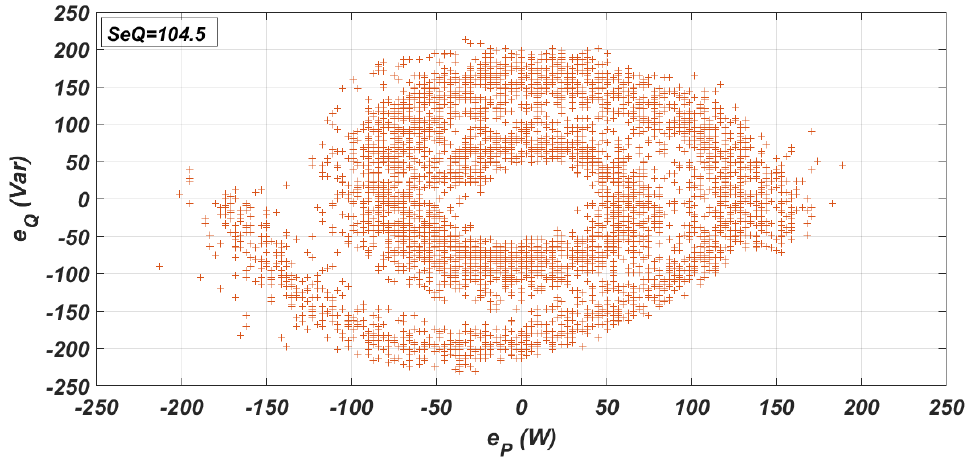
Figure 9. Plot of [ e P ( t ), e Q ( t )] pairs used for the calculation of SeQ for droop control.